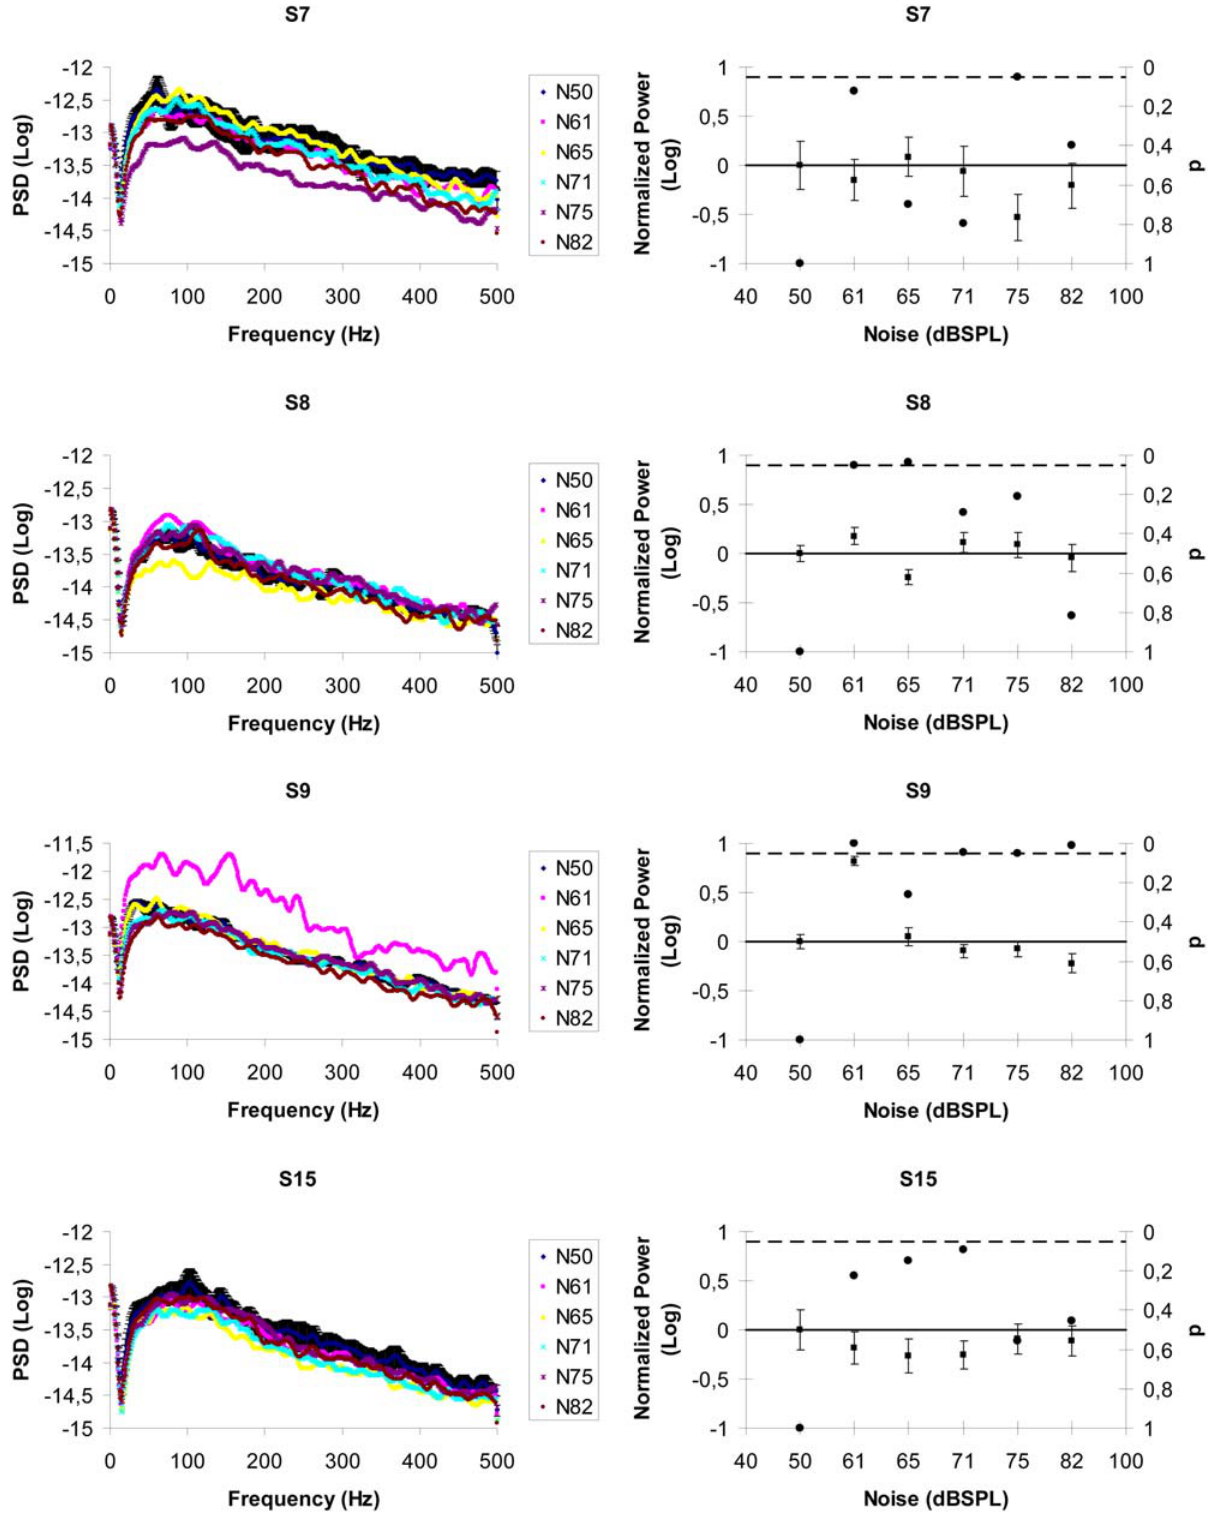
Figure 4. SR interactions between auditory noise and propioceptive signals. (Left column) average EMG power spectral densities as a function of noise level in four subjects for the tightrope posture position. For clarity only the baseline condition shows error bars (one standard error). (Right column) normalized power in four subjects. Again, the no-noise condition is taken as baseline; the black dots indicate p-values (right y-axis) and the broken line represents the 5% significance level. Error bars correspond to one standard error.